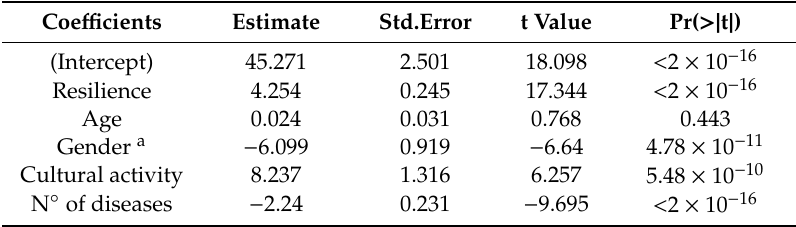
Table 6. Regression models with self-reported psychological well-being (SPWB) as the dependent variable: Model 2b (cultural